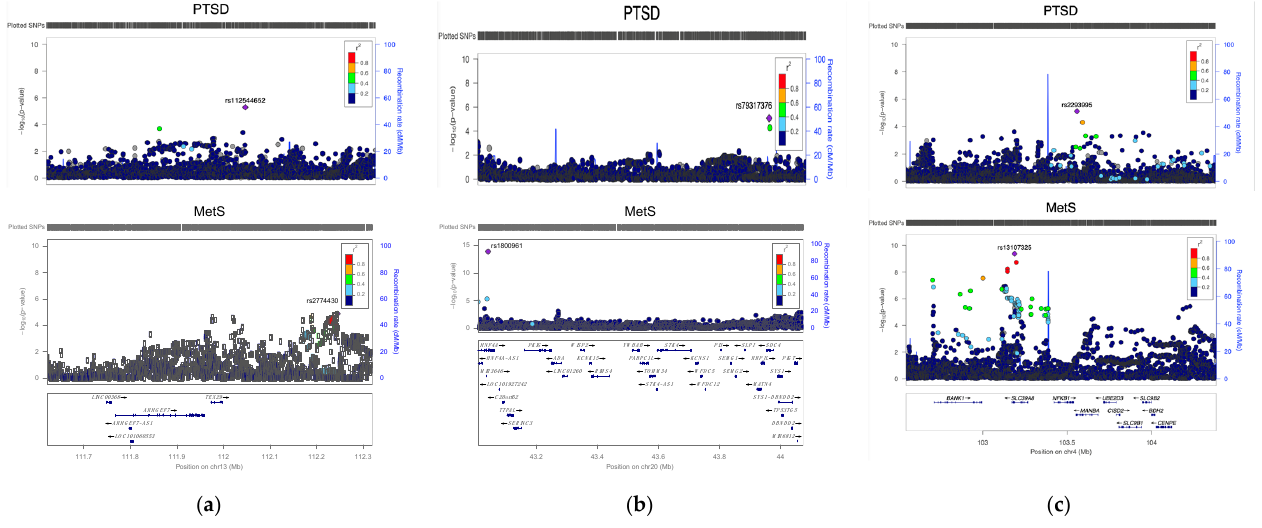
Figure 4. Regional association plots for three loci with significant local genetic correlation between PTSD and MetS. ( a ) 13:111,621,245–112,319,064, ( b ) 20:43,008,891–44,072,210, ( c ) 4:102,544,804–104,384,534.